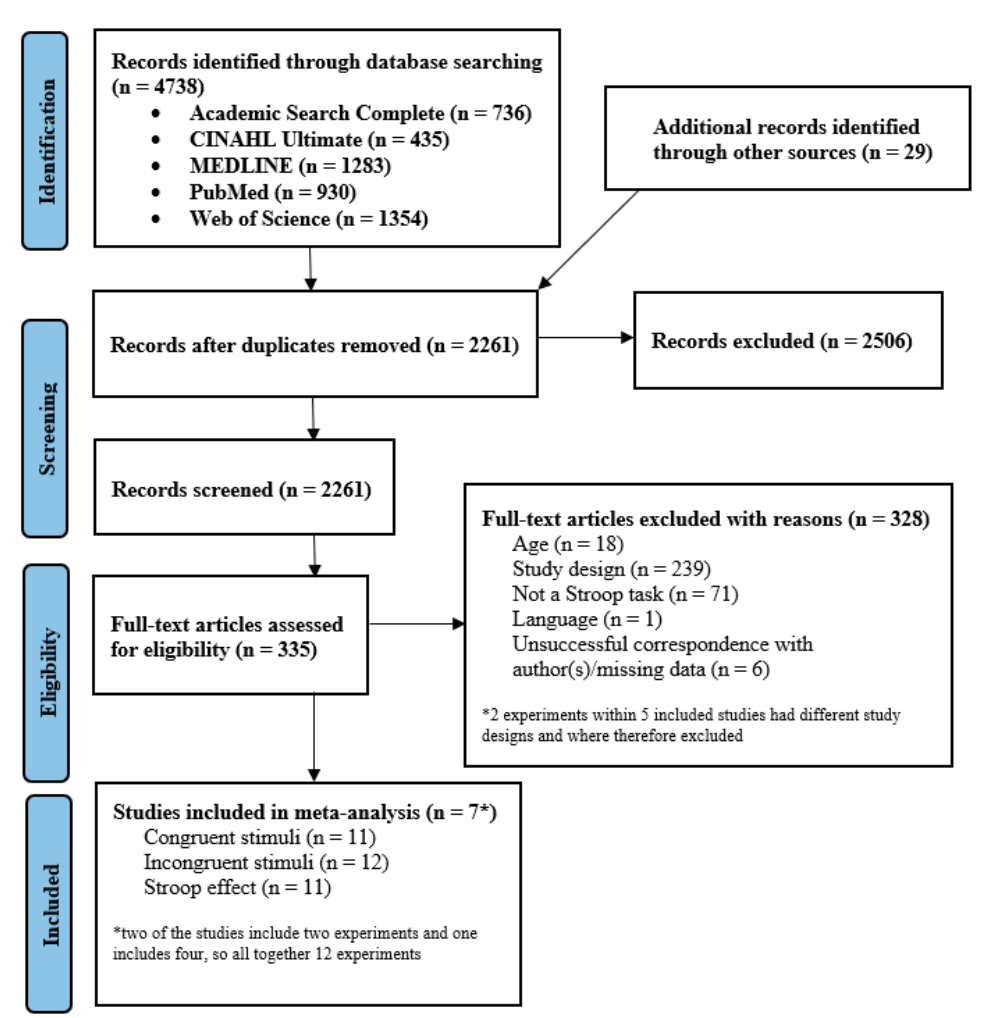
Figure 1. Flow diagram of article screening and selection process.